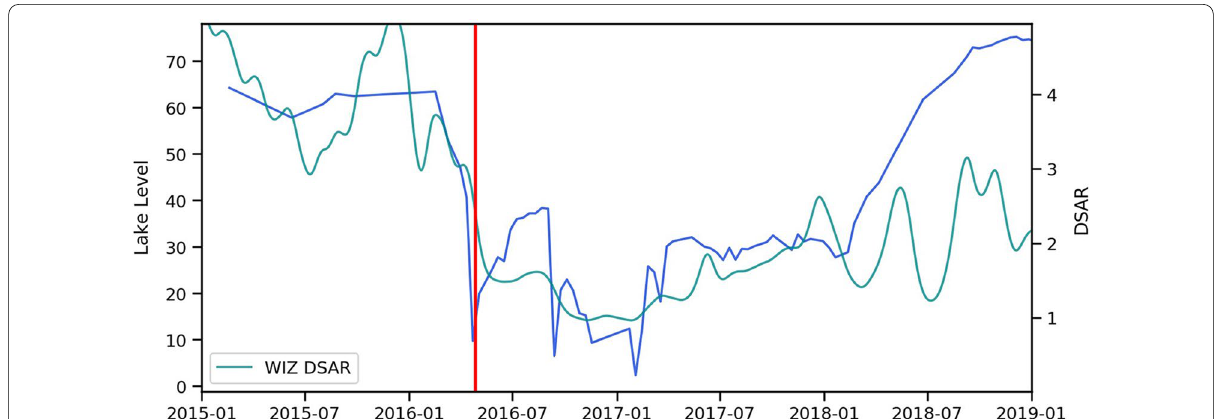
Fig. 7 Comparison DSAR (green) and percentage of lake level (blue) relative to full, i.e., elevated values correspond to higher lake levels (Hamling 2017). See Fig. 4 for the description of the vertical lines corresponding to key time periods. The 1-day DSAR data have been smoothed with a Hendrick Prescott filter, which prevents temporal aliasing (parameter 10 4 =